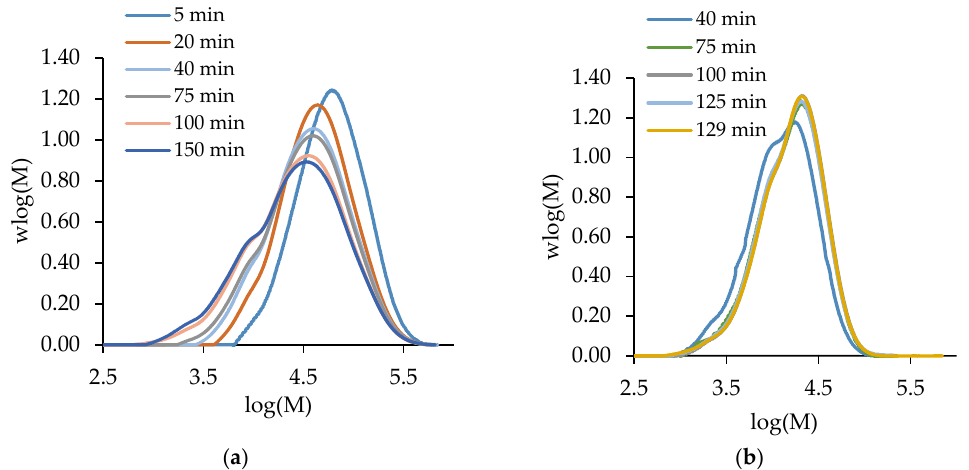
Figure 2. The evolution of polymer MMDs with time for ( a ) batch and ( b ) semi-batch t-BuAAm Figure 2. TheevolutionofpolymerMMDswithtimefor( a )batchand( b )semi-batcht-BuAAm homopoly- homopolymerization with a final monomer/polymer content of 10 wt% synthesized in 75/25 merization with a final monomer/polymer content of 10 wt% synthesized in 75/25 EtOH/H 2 O at EtOH/H 2 O at 60 °C with 1 wt% AIBN. 60 ◦ C with 1 wt% AIBN.